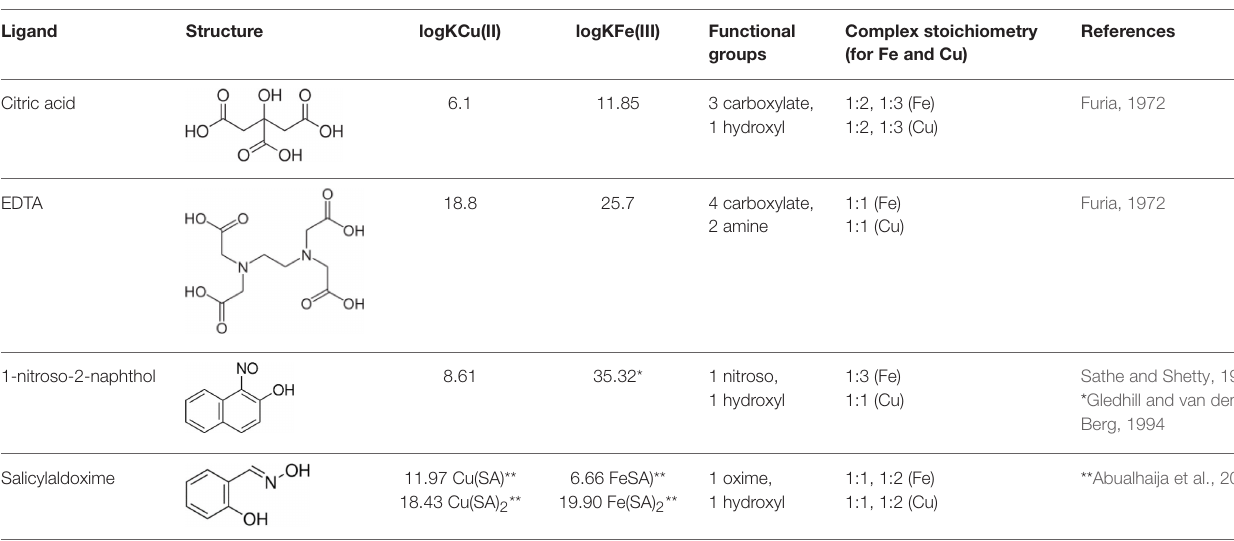
TABLE 1 | Properties of investigated ligands. Ligand Structure logKCu(II) logKFe(III) Functional